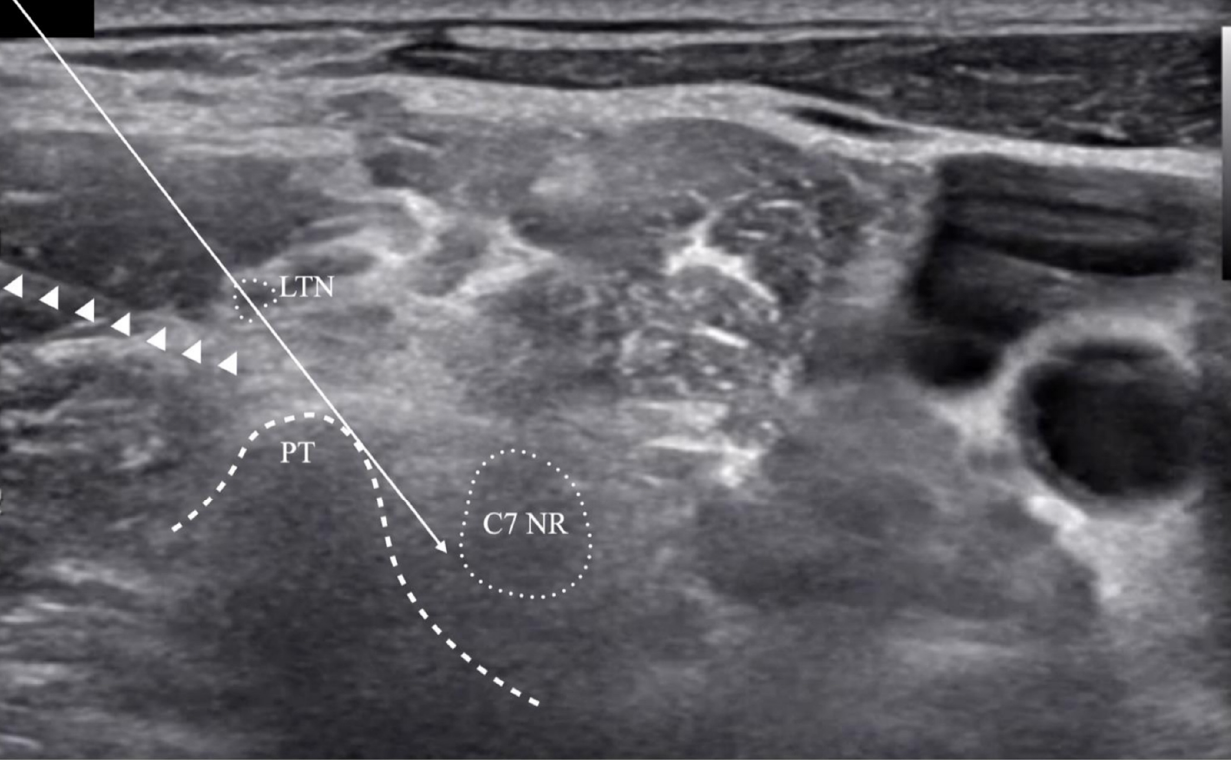
Figure 6. A captured ultrasound image of the C7 selective nerve root block. The arrow is the simulated needle’s trajectory. The long thoracic nerve (LTN) is in the middle of the trajectory; thus, the needle’s direction (arrowheads) should be modified. PT, posterior tubercle; NR, nerve root.